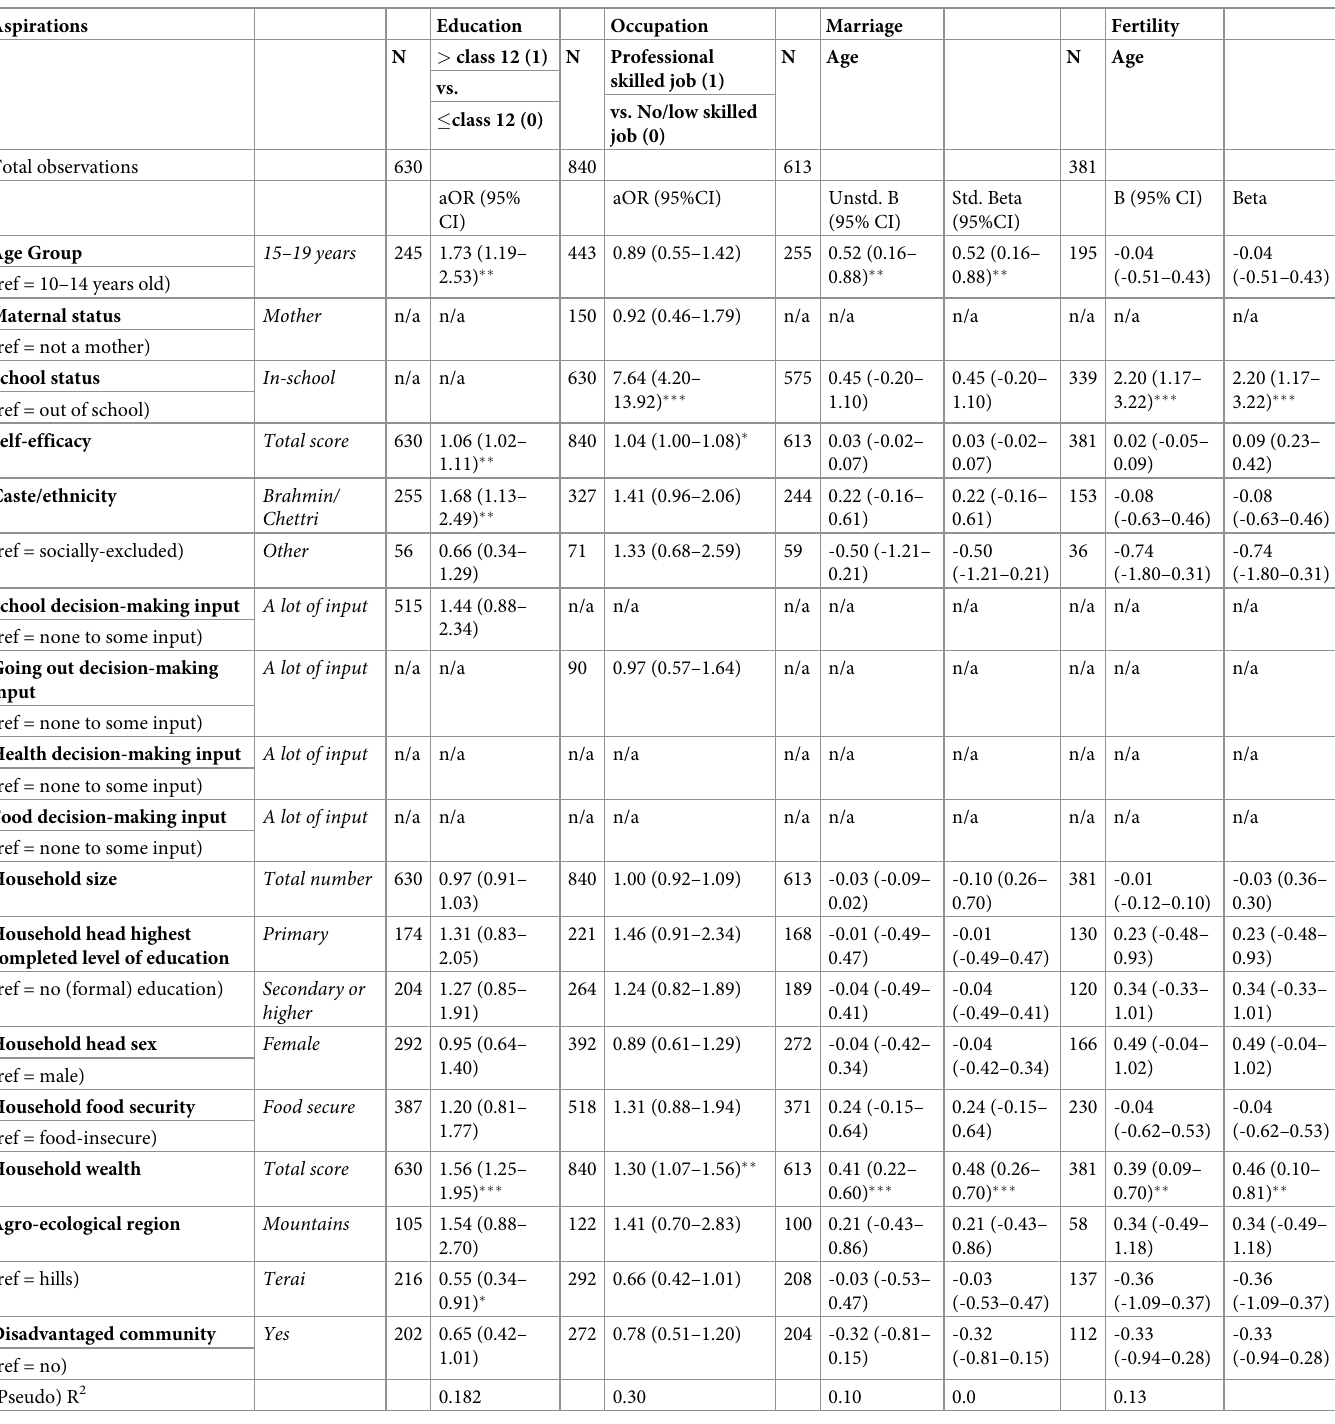
Table 3. Regression results for educational, occupational, marital, fertility, health, and nutrition